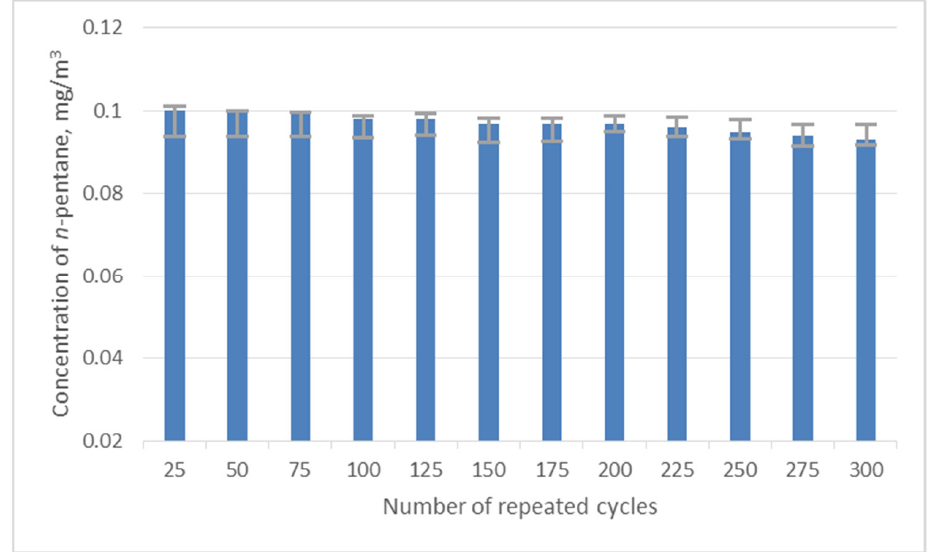
Figure 2. Graph showing the concentration of the n-pentane as the function of number of cycles for the n-octane ResSil-C sorbent.